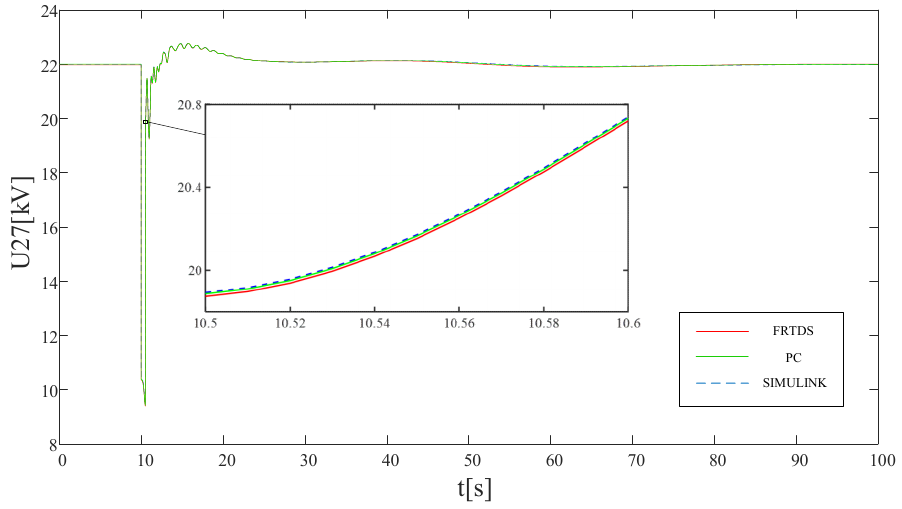
Figure 11. The voltage amplitude of bus 27.